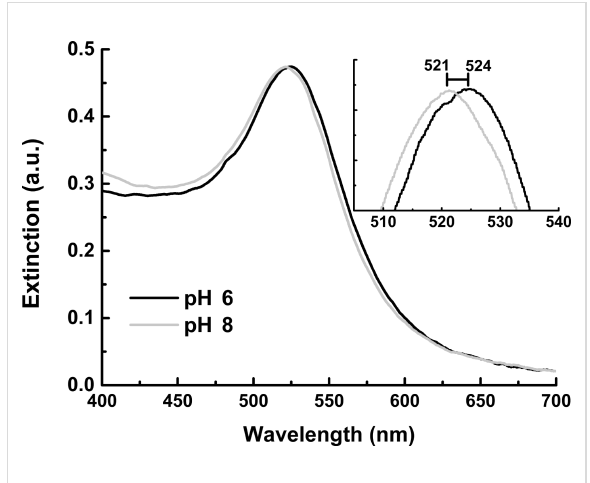
Figure 7: Normalized extinction spectra (400–700 nm) of AuNPs after the non-specific adsorption of BiotinDNA (no streptavidin) at different pH values.